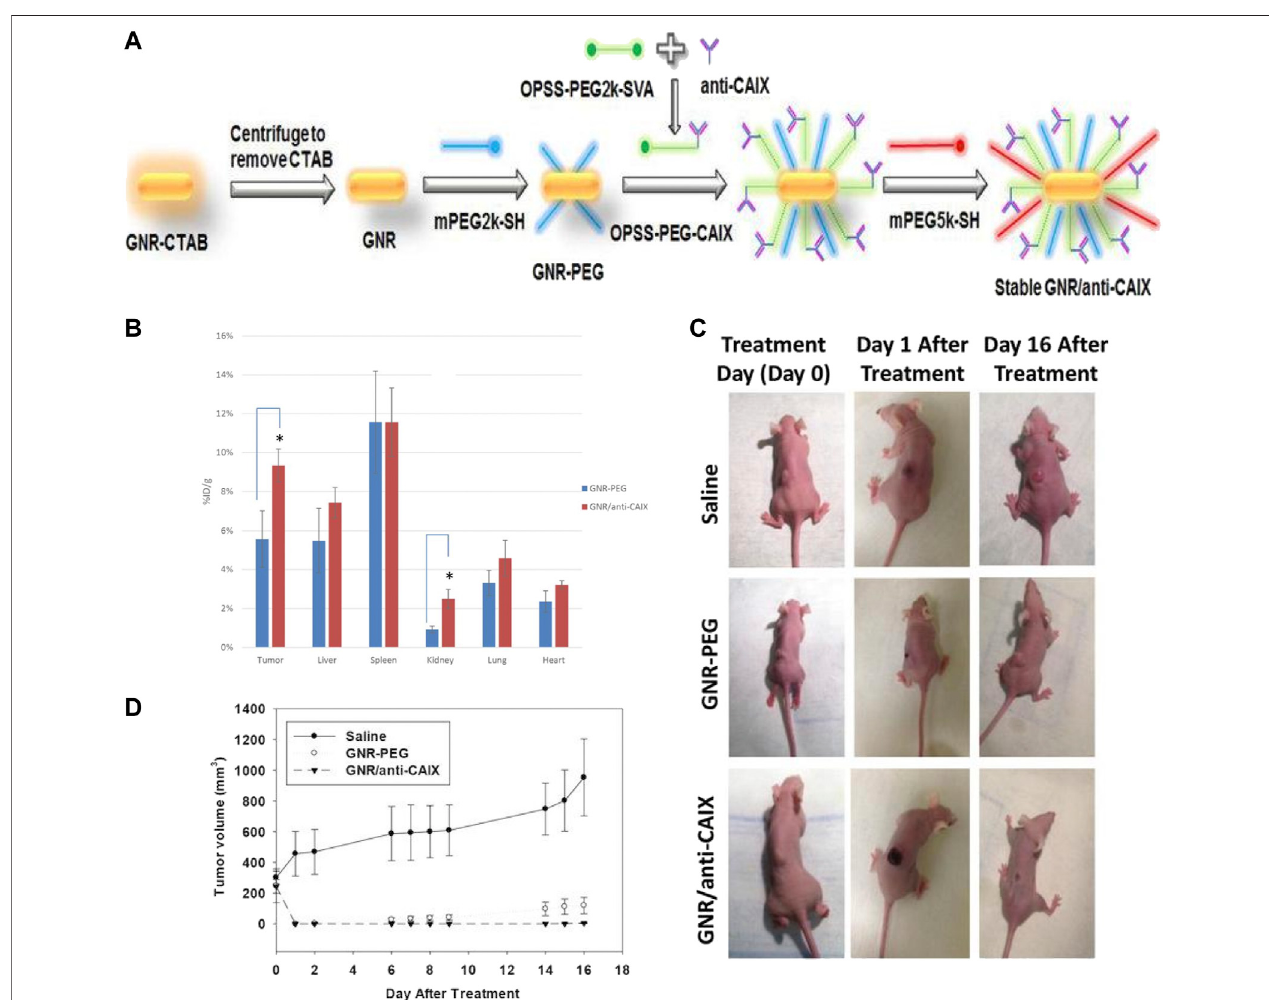
FIGURE 6 | The preparation and properties of hypoxia-targeted GNRs. (A) The preparation of hypoxia-targeted GNRs. The conjugation of GNRs with anti-CAIX antibody via bi-functional crosslinker. (B) Comparison of gold content in tissues by Inductively Coupled Plasma-Mass Spectrometry (ICP-MS) 24 h after intravenous administrationoftargeted(GNRs/anti-CAIX)anduntargeted(GNRs-PEG)GNRsinHT29-tumor-bearingmice( n (cid:1) 4forbothgroups).TheuptakeofGNRs/anti-CAIXwas signi fi cantlyhigherthanGNRs-PEGinxenografttumor(* p < 0.05).Thebiodistributioninotherorganswassimilarforbothgroupsexcepthigheruptakeinthekidney for GNRs/anti-CAIX. (C) Photothermal ablation via near infrared irradiation of HT29 tumors 24 h after tail-vein injection of saline (n (cid:1) 3), GNRs-PEG ( n (cid:1) 5, OD (cid:1) 20) or GNRs/anti-CAIX ( n (cid:1) 7, OD (cid:1) 20). Images of representative mice in each group prior to treatment, one day after treatment, and 16 days after treatment. Tumor volume plotted over time for all three groups. (D) No tumor regression in the saline-treated group; regression but recurrence of tumor in the GNRs-PEG treated group; and complete tumor regression in the GNRs/anti-CAIX treated group (Chen et al., 2018a). (Hypoxia-targeted gold nanorods for cancer photothermal therapy, https://